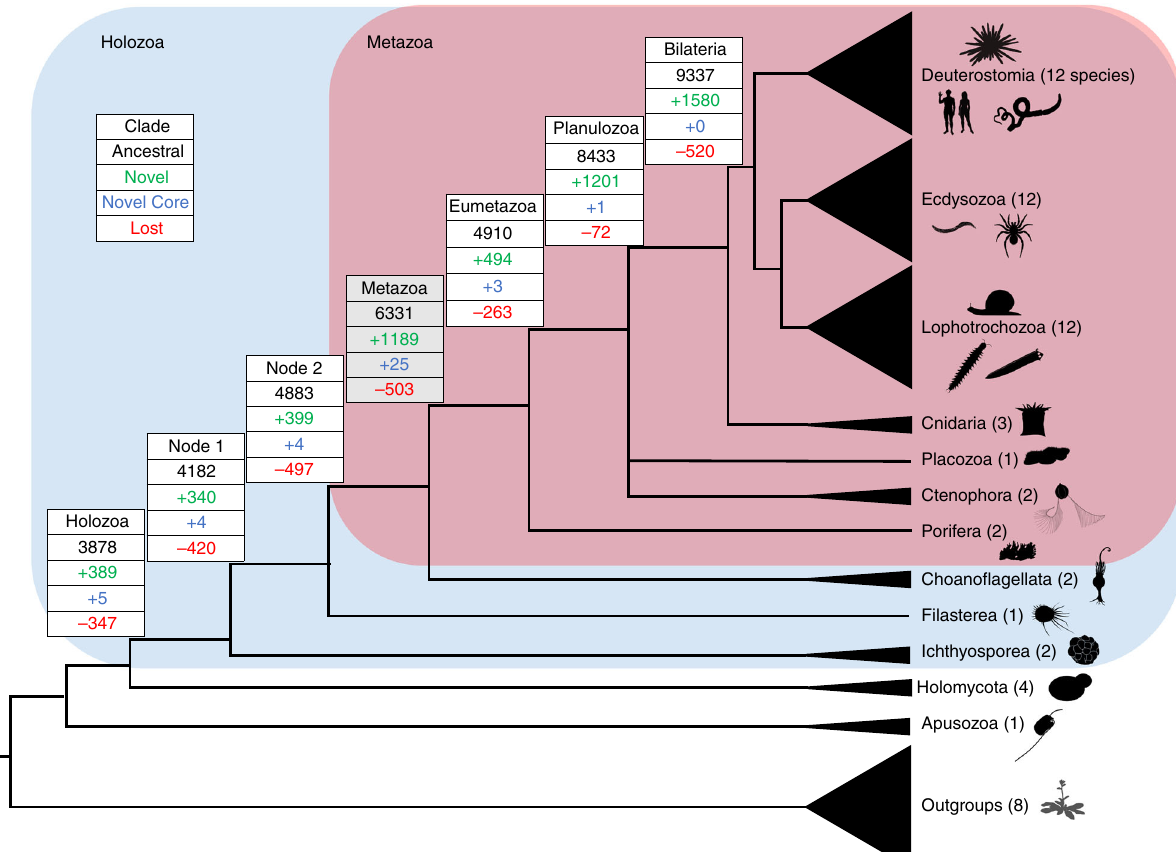
Fig. 1 Reconstruction of ancestral genomes. Evolutionary relationships of the major groups included in his study 2 . Different categories of HG are indicated in each node, from top to bottom, Ancestral HG, Novel HG, Novel Core HG, and Lost HG. Values assume sponges as the sister group to other animals, and placozoans as sister group to Planulozoa ( = Cnidaria + Bilateria); alternative phylogenetic hypotheses are explored in Supplementary Data 3-8. Organism outlines from phylopic.org and the